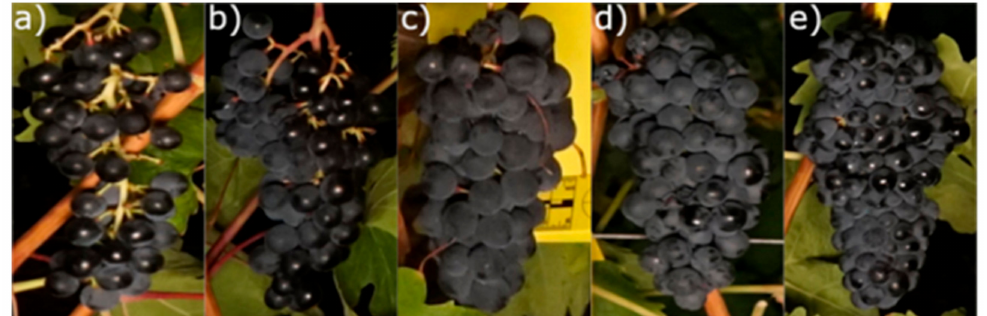
Figure 2. Examples of clusters with di ff erent compactness ratings according to the International Organization of Vine and Wine (OIV) 204 standard: class 1 ( a ) very loose clusters; class 3 ( b ) loose clusters; class 5 ( c ) medium compact clusters; class 7 ( d ); compact clusters; class 9 ( e ) very compact clusters.